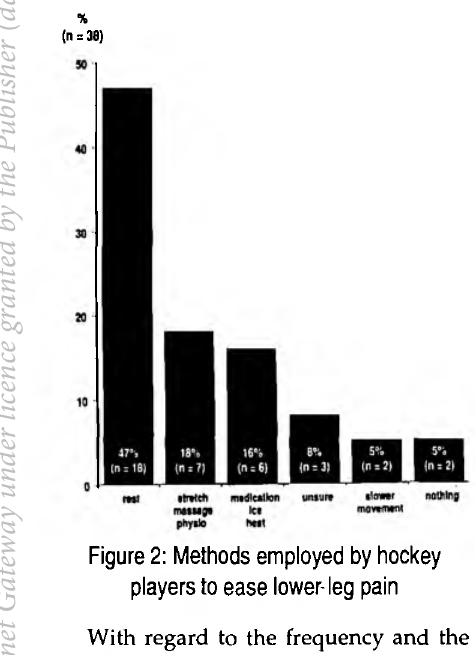
Figure 2: Methods employed by hockey players to ease lower-leg pain With regard to the frequency and the duration of the lower leg pain, 88% (n=37) of the symptomatic players had experi­ enced the lower leg pain more than twice, 51% (n-21) reported that the pain lasted Phys.